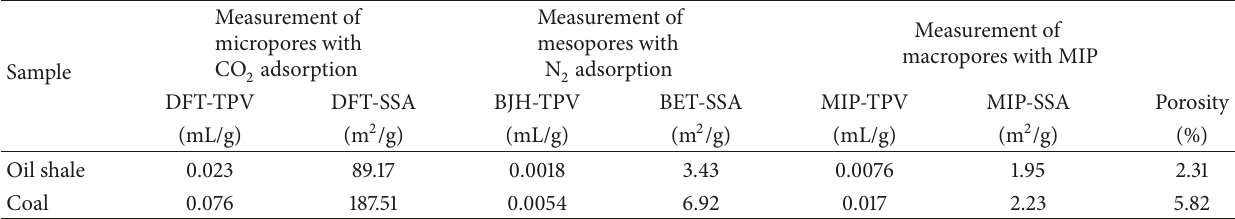
Table 2: Pore structure analyses of the oil shale and coal